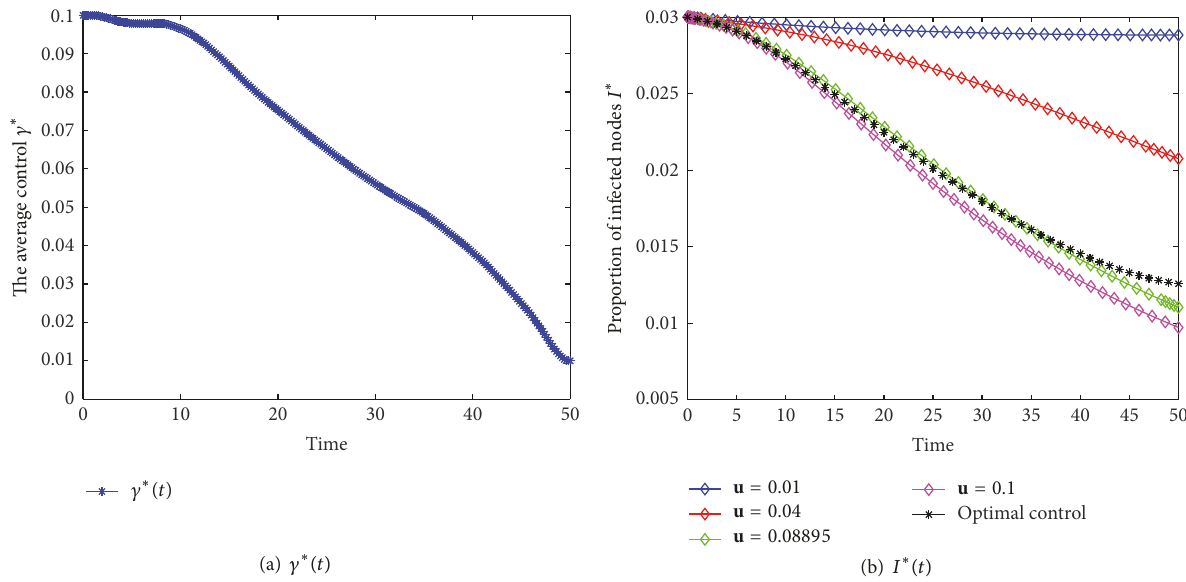
Figure 7: 𝛾 ∗ (𝑡) and 𝐼 ∗ (𝑡) under different control strategies with 𝑚 1 = 𝑚 2 = 2 for Example 2.